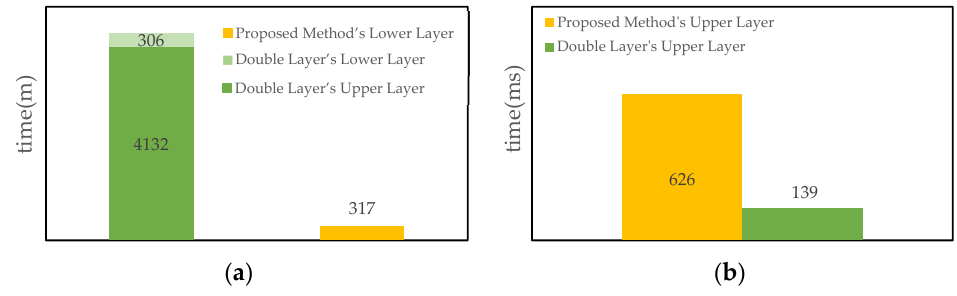
Figure 10. Comparison of learning time and calculation time between the traditional double lay- ered A3C and the proposed approach. ( a ) Learning time comparison. The y -axis is time (min). ( b ) Calculation time comparison. The y -axis is time (ms).